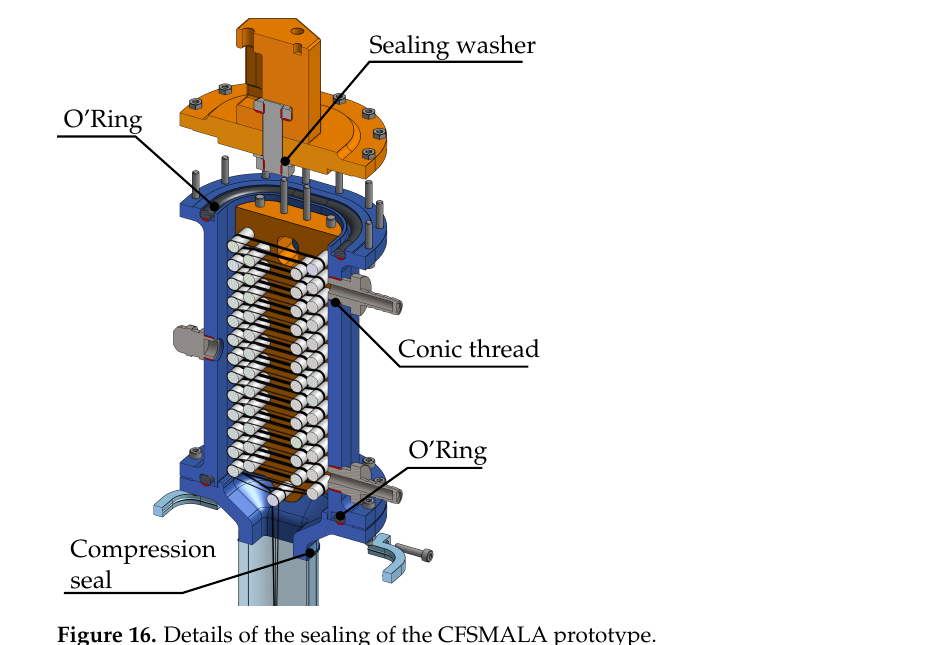
Figure 16. Details of the sealing of the CFSMALA prototype.